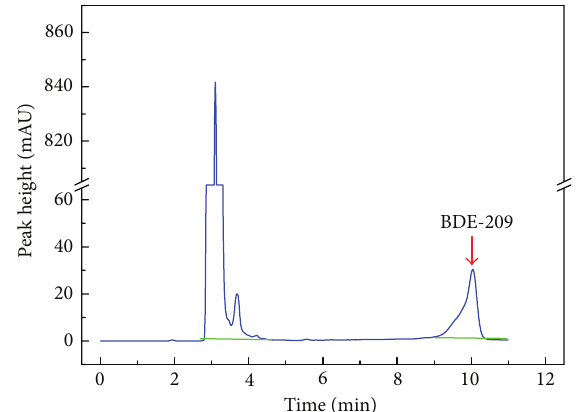
Figure 1: The peak deformation difference of BDE-209.